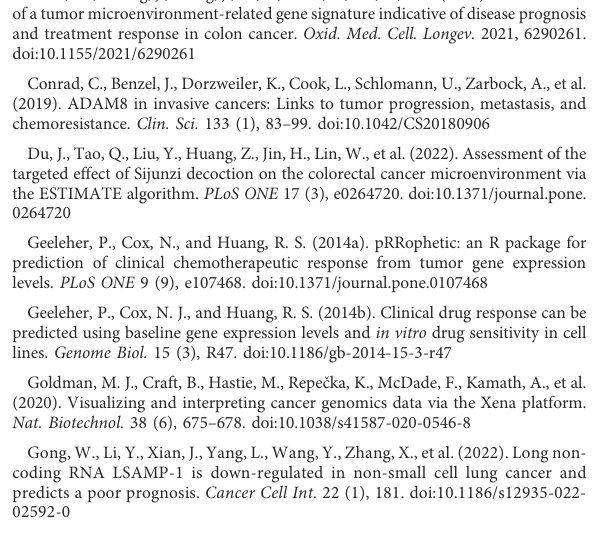
SUPPLEMENTARY FIGURE S1 Alterations of CAFs-related genes in CRC patients from TCGA. SUPPLEMENTARY FIGURE S2 The Kaplan-Meier survival curves of OS between highly expressed and lowly expressed CAFs-related genes. SUPPLEMENTARY FIGURE S3 The differences in CAFs risk scores between different cancer types (A) , clinical stages (B) , lymphatic invasion (C) , and TNM stage (D,F) . SUPPLEMENTARY FIGURE S4 Correlation between CAFPS and 50 cancer hallmark-related pathways. SUPPLEMENTARY FIGURE S5 The top30mostrelevant drugsfor 20prognostic geneswereshown bya bubble